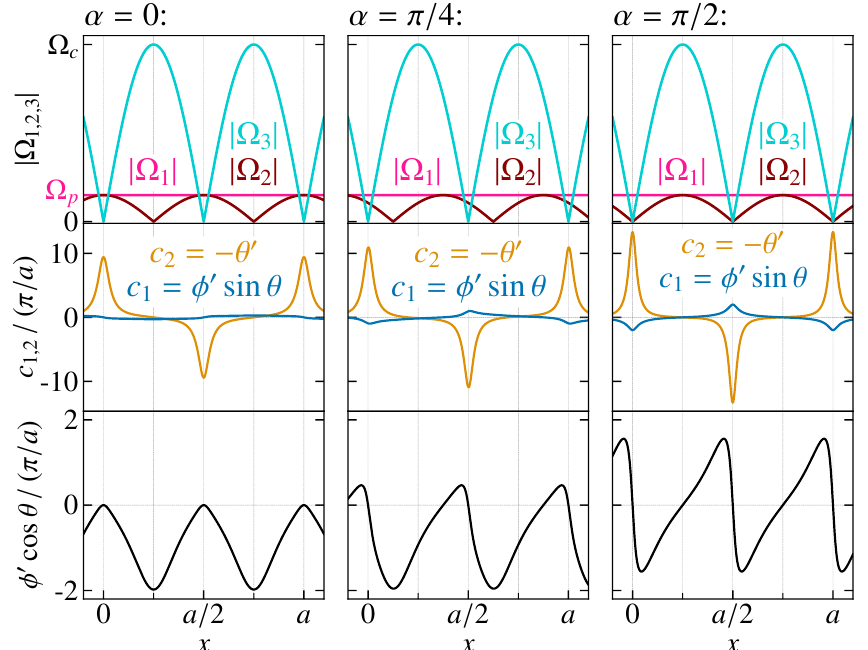
( x ) (first row), the quantities 1,2,3 ( x ) in Eq.(20) D / Ω = 0.15 and various values of α p c